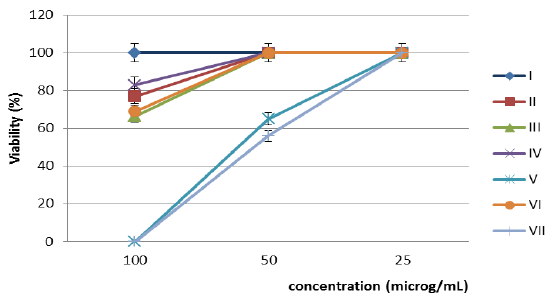
Figure 4. Viability (%) of HeLa cells after 24 h treatment with different concentrations of the obtained nanoparticles.